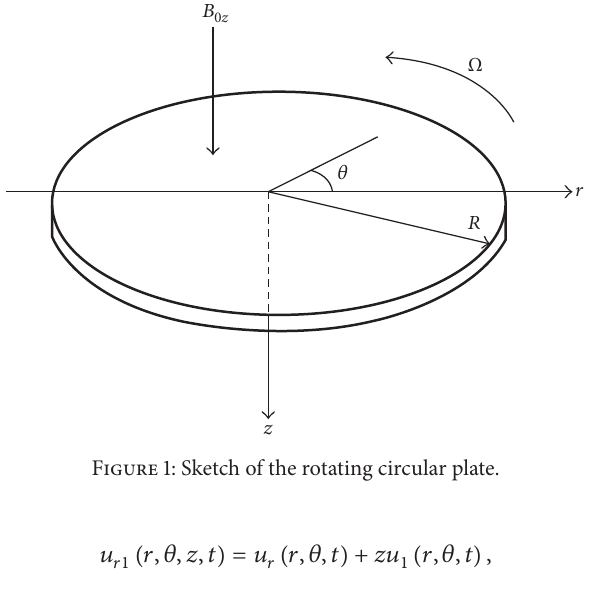
Figure 1: Sketch of the rotating circular